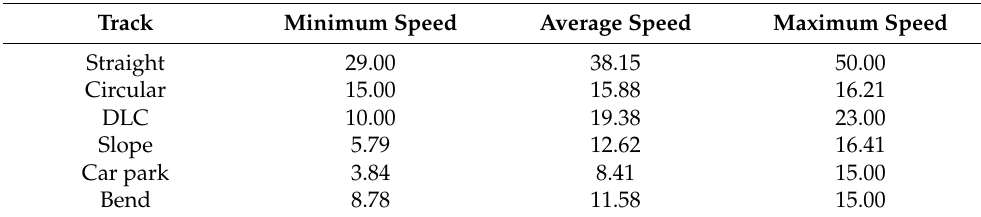
Table 3. Speeds used for the maneuvers in every test track (in